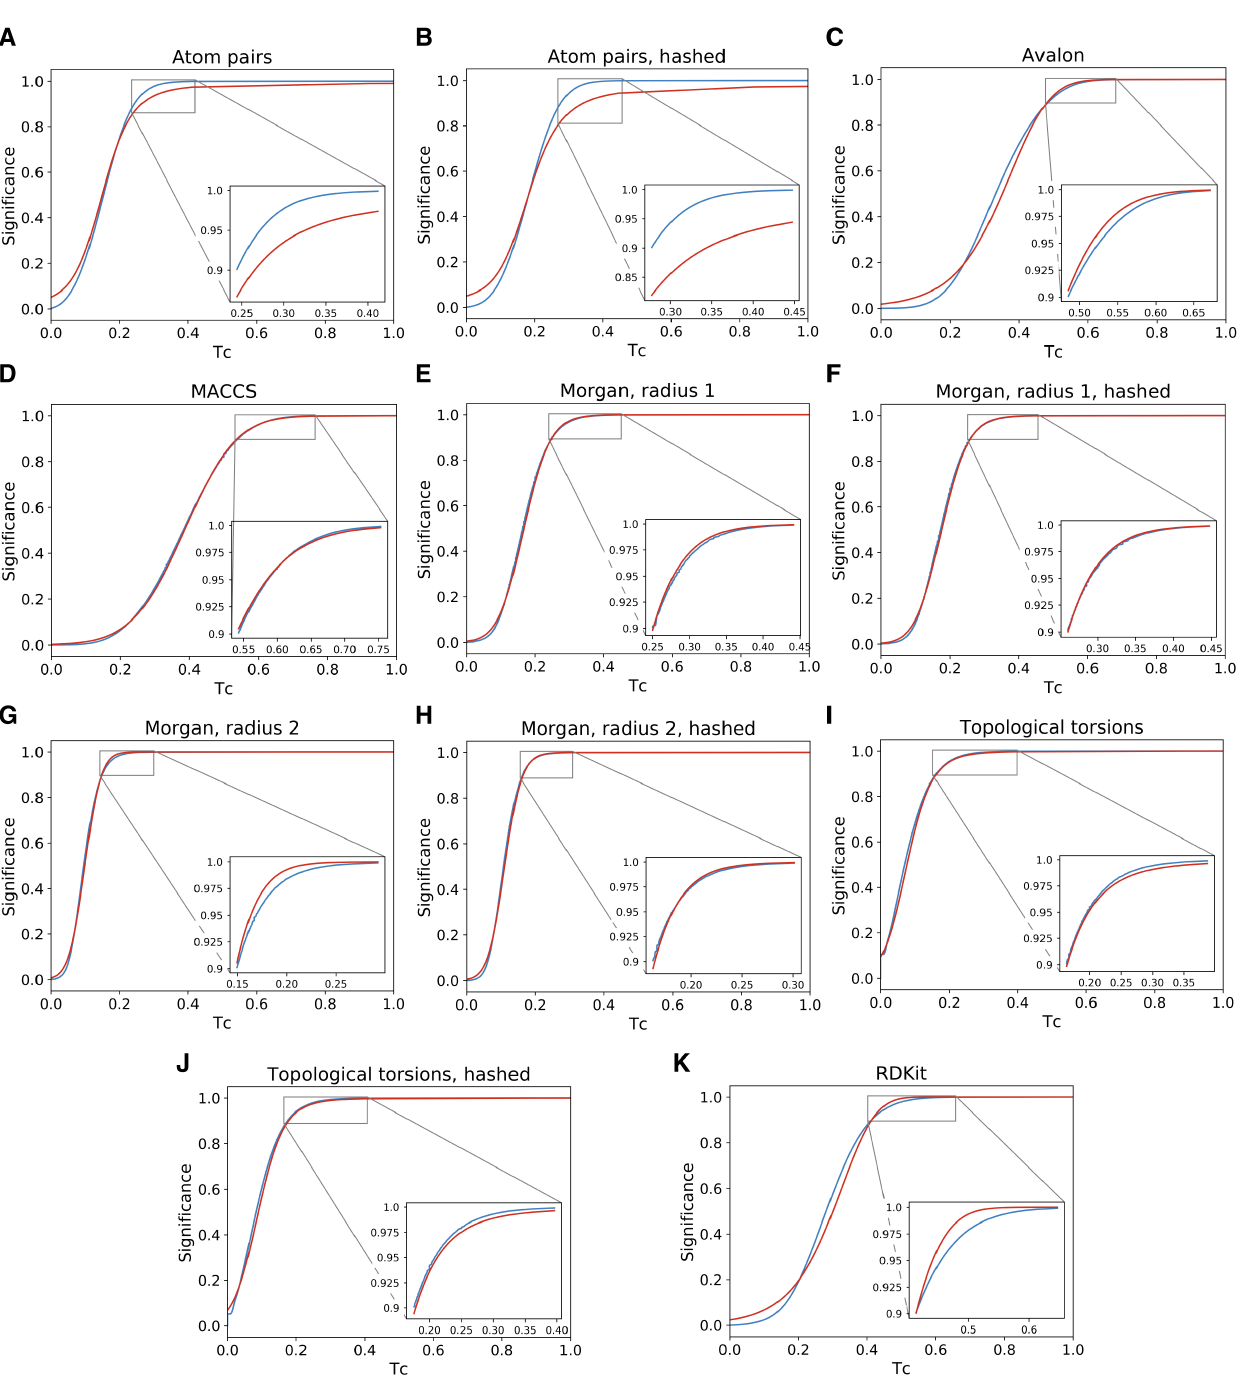
Figure 1. Empirical and modeled cumulative distribution functions. The empirical and modeled cumulative distribution functions for the fingerprints reported in Table 1 are shown in ( a ) – ( k ). Blue lines indicate empirical distributions obtained from randomly sampling 1,000,000 pairs of compounds from ChEMBL. Red lines show the corresponding modeled distributions according to Equation (16). The inserts highlight the correspondence between the curves for Tc values of high